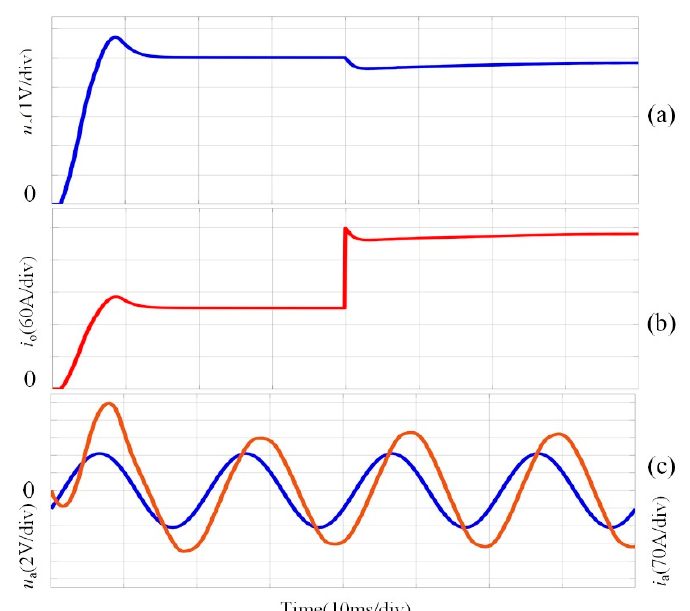
Figure 10. Simulation waves of the disturbed direct power control: ( a ) Voltage wave; ( b ) current wave; ( c ) A-phase voltage and current waves.